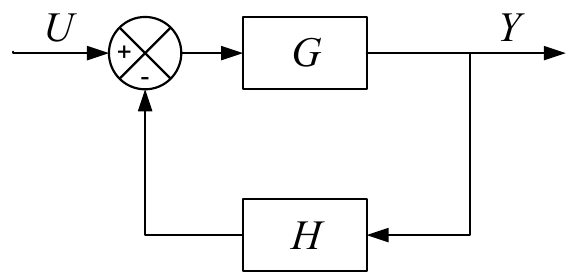
Figure 4. Negative Feedback Control